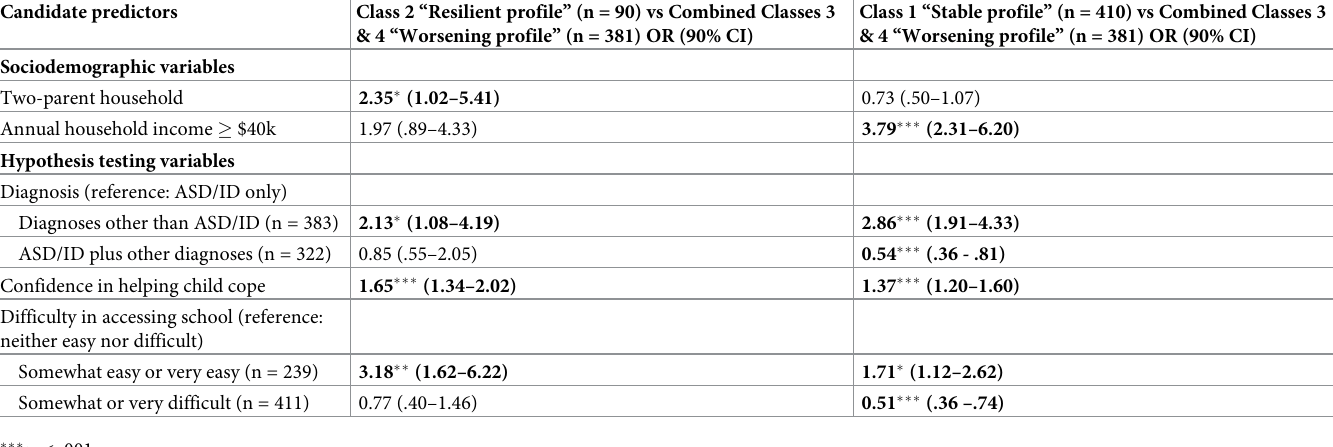
Table 4. Multinominal logistic regression to examine association between candidate predictors and class membership. Candidate